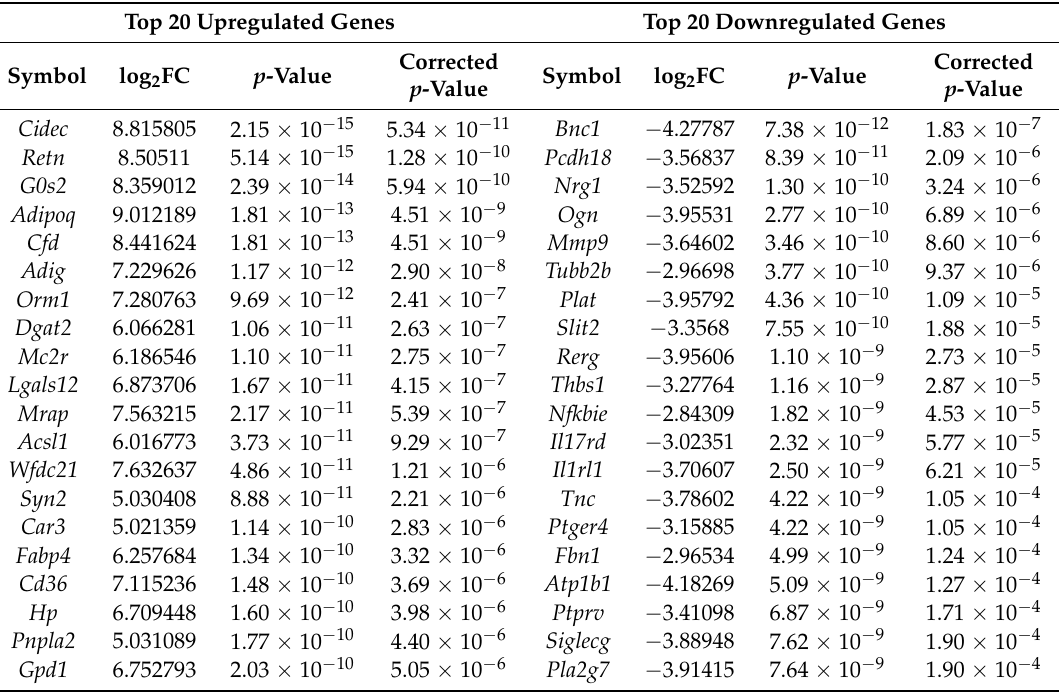
Table 2. Top 20 up- and down-regulated DEGs identified during adipogenesis via integrated analysis. Top 20 Upregulated Genes